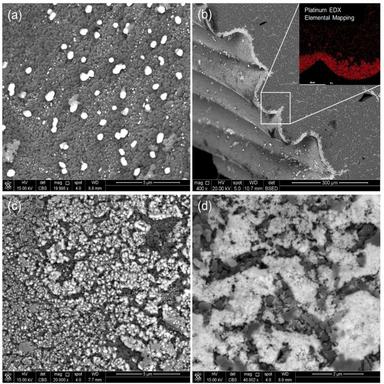
SEM images of the Pt catalyst coatings; (a) Pt on alumina from TAPCl precursor – 800 ◦C in H2 with (b) EDX mapping on cross section, (c) & (d) Pt on alumina from H2PtCl6 precursor – 800 ◦C in H2.